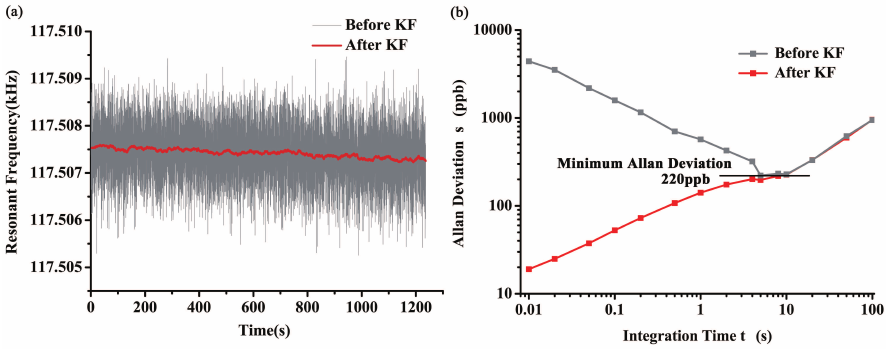
Figure 11. ( a ) Static frequency data of DETF B before and after Kalman Filter; ( b ) Allan deviation of the static frequency data with different parameter R.